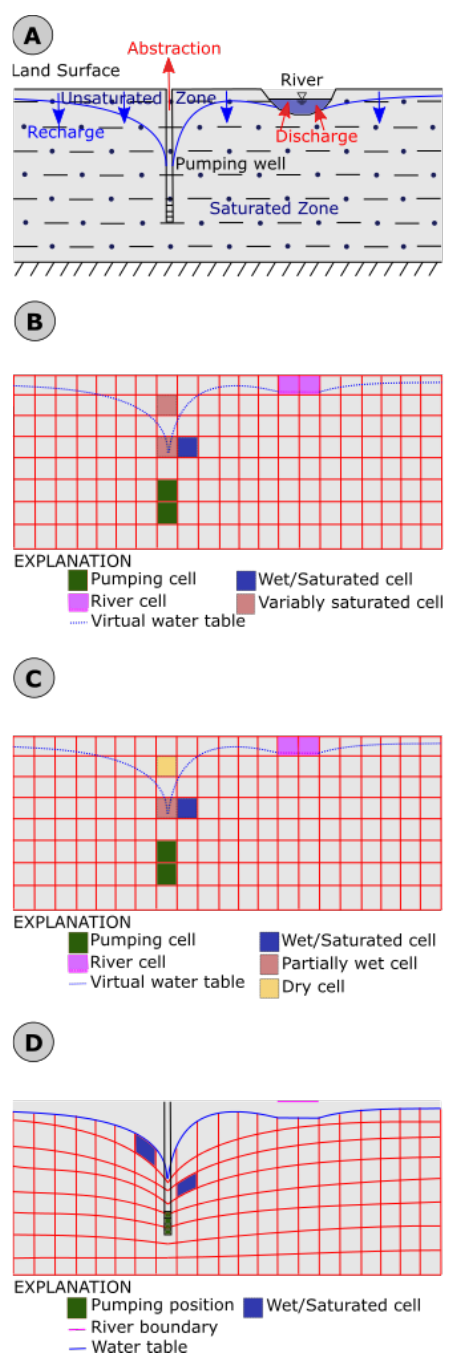
Figure 1. Illustration of different approaches for modeling unconfined groundwater flow in sub- surface aquifers. ( A ) An example of flow processes occurring in an unconfined aquifer such as recharge, abstraction, and aquifer-river interactions. ( B ) A discrete variably saturated groundwater flow model seeks to determine the saturation state in all cells; the water table shape and position are post-processed from simulated pressure heads. ( C ) A discrete unconfined flow model neglecting processes in the unsaturated zone using a fixed mesh. The numerical model identifies wet, partially wet, and dry cells. The water table is not represented explicitly and is post-processed from simulated heads. ( D ) A discrete unconfined flow model neglecting processes in the unsaturated zone using a moving mesh. The numerical model works exclusively with fully saturated cells. The water table is explicitly represented by the upper mesh slice and is, therefore, not